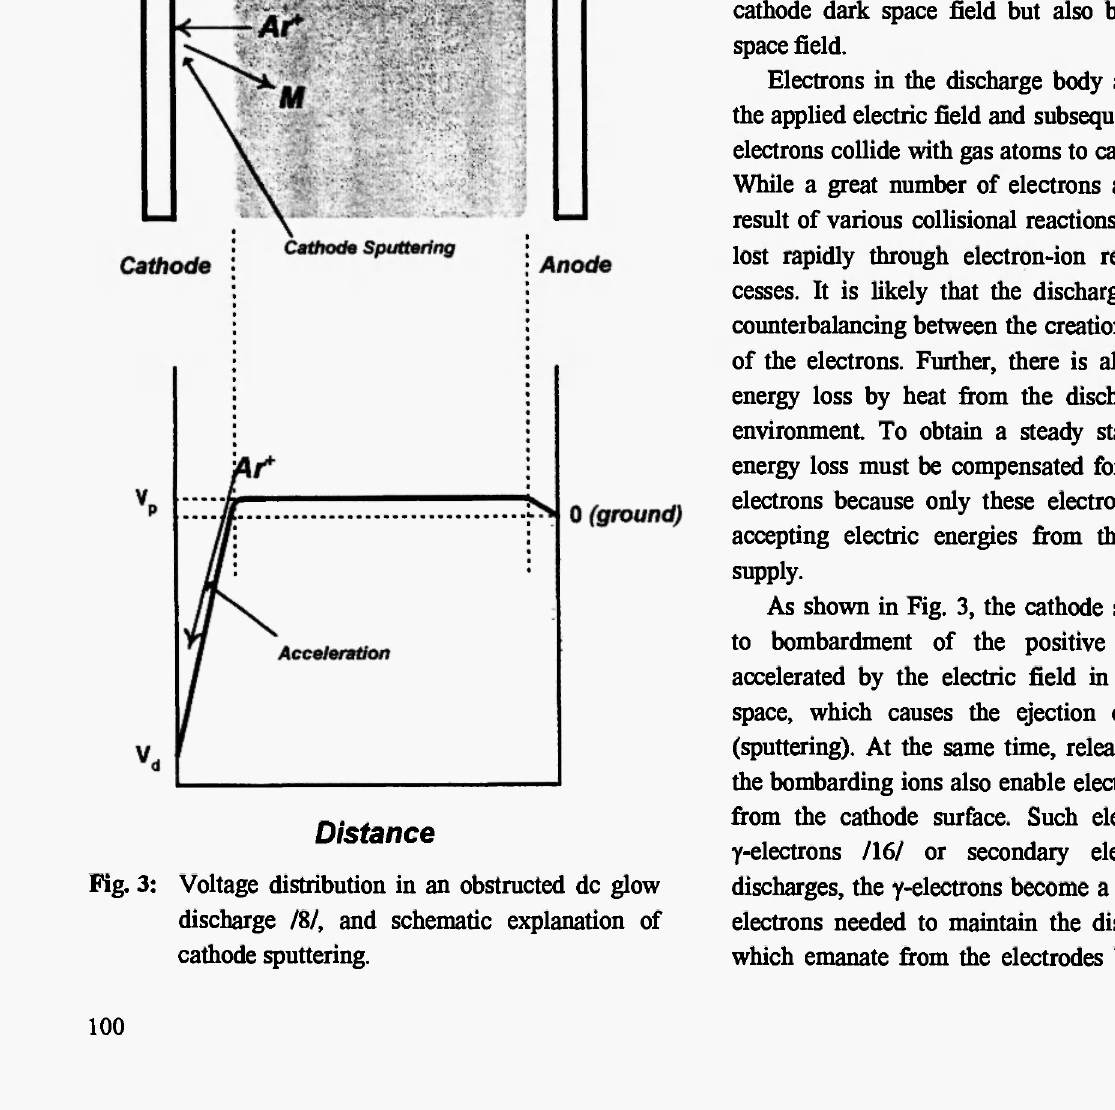
Fig. 3: Voltage distribution in an obstructed dc glow discharge /8/, and schematic explanation of cathode